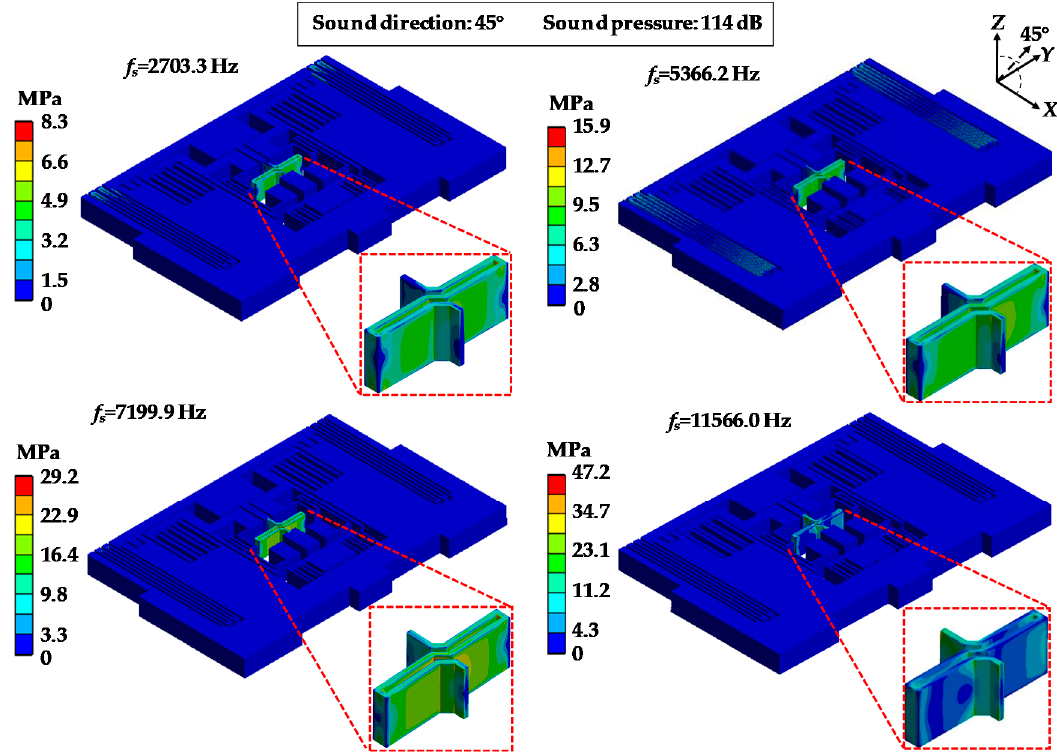
Figure 8. Equivalent stress distributions of MPU6050-Y under acoustic injection of different sound frequencies.